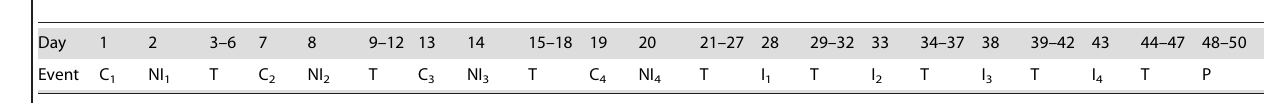
Capitals refer to the test phases as described in Table 1. ‘‘T’’ indicates continued training on the foraging tasks. Subscripts indicate the test trial numbers for the Control, No-Interaction and Interaction test